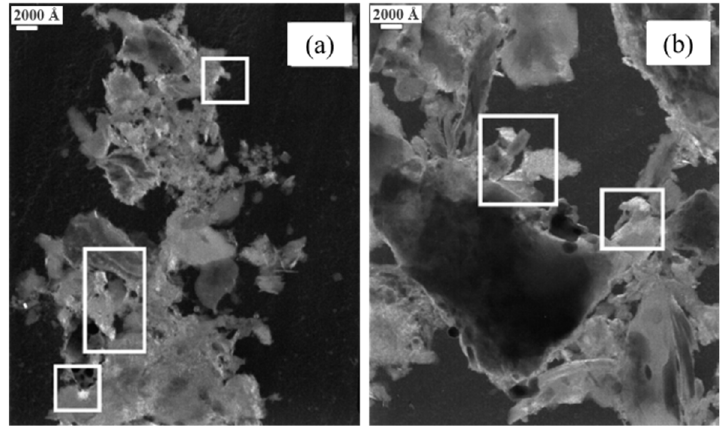
Figure 15. The MODs in the coke microregion: ( a ) without reaction; ( b ) reaction with CO 2 [18]. High-Resolution Transmission Electron Microscopy (HRTEM)